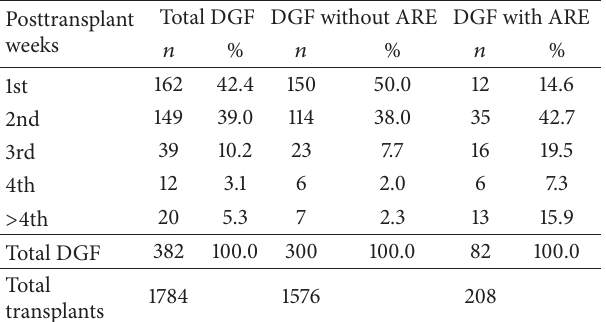
Table 2: Delayed graft function (DGF) in transplants with and without acute rejection episodes (ARE) occurring during the DGF period.